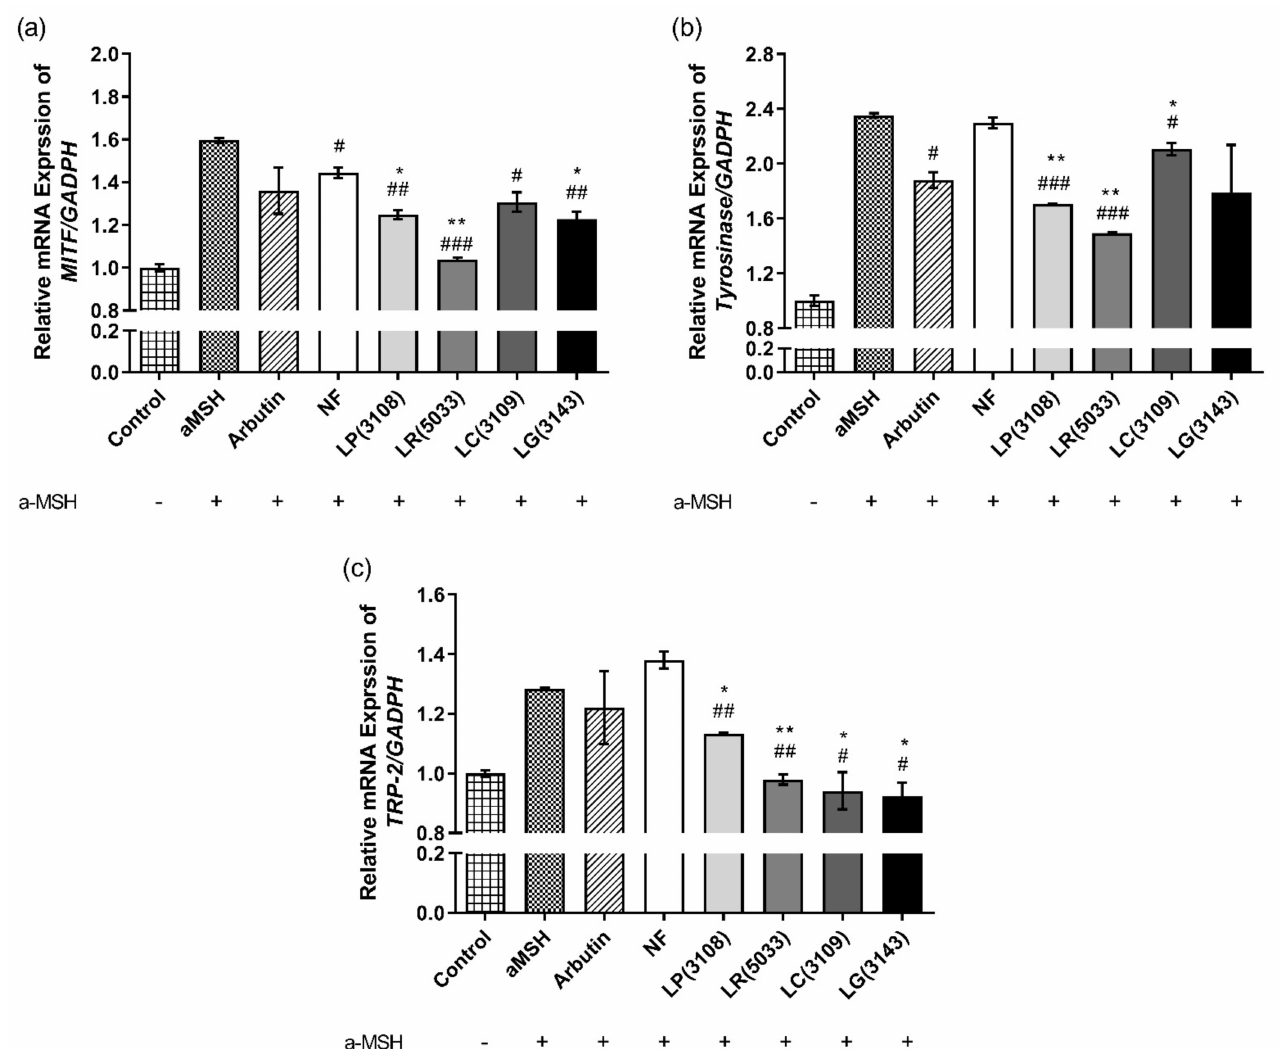
Figure 10. Effects of non-fermented and fermented maca root extracts on the relative mRNA ex- pression of ( a ) MITF, ( b ) tyrosinase, and ( c ) TRP-2 in B16F10. Error bars, mean ± SD. # p < 0.05, ## p < 0.005, and ### p < 0.0005 compared to the α -MSH group. * p < 0.05 and ** p < 0.005 com- pared to the non-fermented maca root extract group. NF, non-fermented; LP(3108), Lactiplantibacillus plantarum subsp. plantarum KCTC 3108; LR(5033), Lacticaseibacillus rhamnosus KCTC 5033; LC(3109), Lacticaseibacillus casei KCTC 3109; LG(3143), Lactobacillus gasseri KCTC